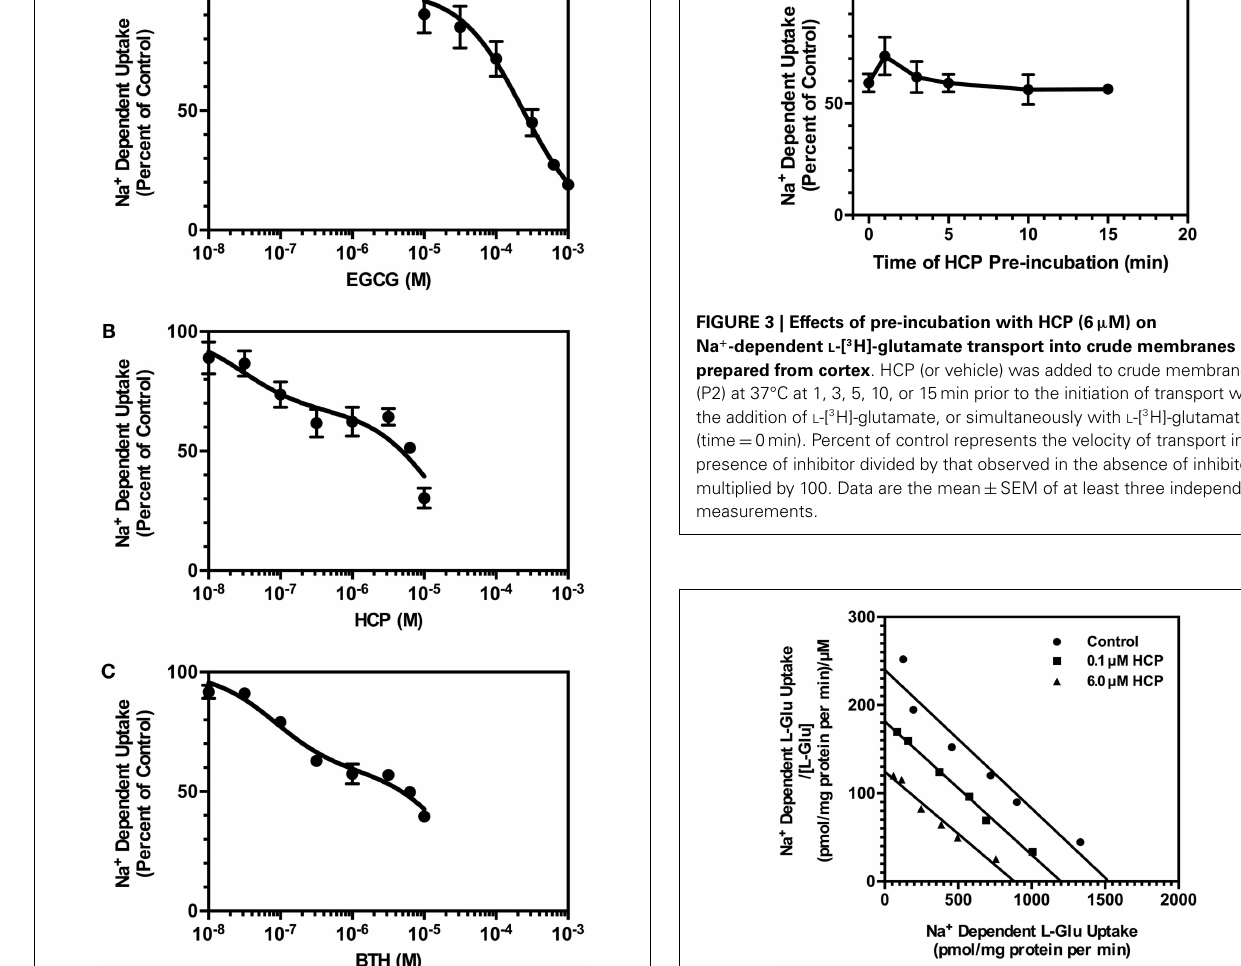
FIGURE 2 | Concentration-dependence of the effects of GDH inhibitors on of Na + -dependent L -[ 3 H]-glutamate transport into crude membranes (P2) prepared from cortex .Transport of L -[ 3 H]-glutamate (0.5 µ M) was measured in the absence or presence of increasing concentrations of inhibitors, as described in Section “Materials and Methods.”The percent of control represents the velocity of transport measured in the presence of inhibitor divided by that observed in the absence of inhibitor multiplied by 100. (A) Inhibition by EGCG was fit to a one-site competition model with an IC 50 value of 234 µ M. (B) Inhibition by HCP was fit to a two-site competition model.The IC 50 value for the high affinity component was 30nM, and the IC 50 value for the lower affinity component was 14 µ M. Based on this fit, 33% of the sites were high affinity and 67% were of lower affinity. (C) Inhibition by BTH was fit to a two-site competition model with an IC 50 for fraction 1 (42%) of 84nM and an IC 50 for fraction 2 (58%) of 26 µ M. Data are the mean ± SEM of at least three independent measurements (except for incubation of 1 µ M BTH, of which there were only two observations).